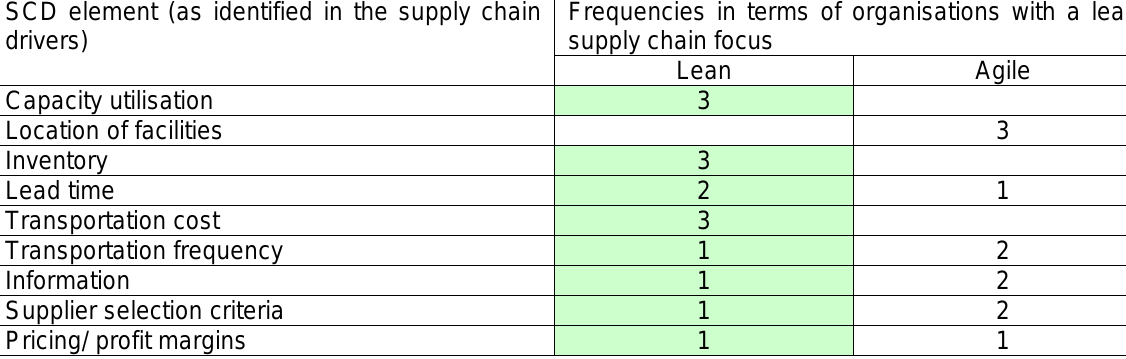
Table 7: Responses from organisations (with a lean supply chain focus) in terms of the management of their supply chain drivers ( n =